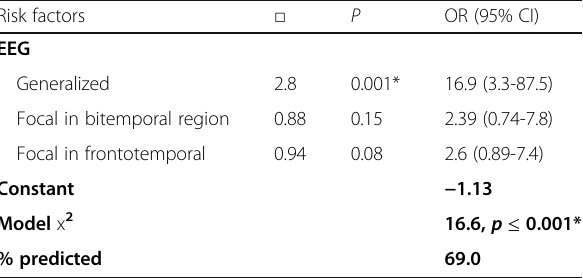
Table 5 Stepwise Logistic regression analysis of risk factors between enuresis only group and enuresis with ADHD group Risk